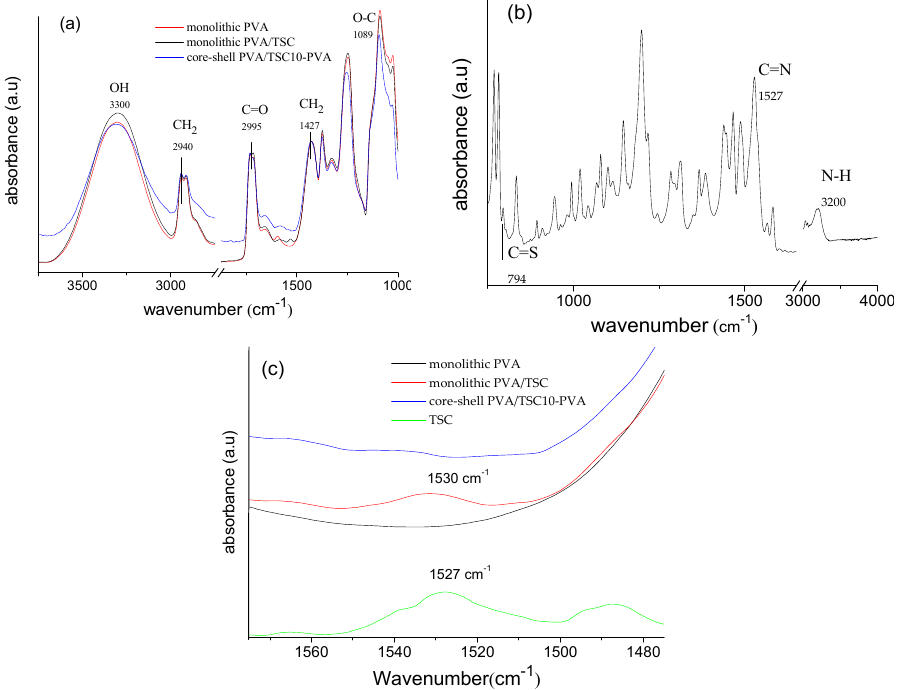
Figure 5. Normalized attenuated total reflection Fourier-transform infrared (ATR-FTIR) spectra of ( a ) monolithic PVA and PVA / TSC5 fiber mats. ( b ) HapyTSCmB, ( c ) monolithic PVA, PVA / TSC5, and core–shell PVA / TSC10-PVA fibers. The spectra were normalized based on the 1427 cm − 1 CH 2 bending vibration.